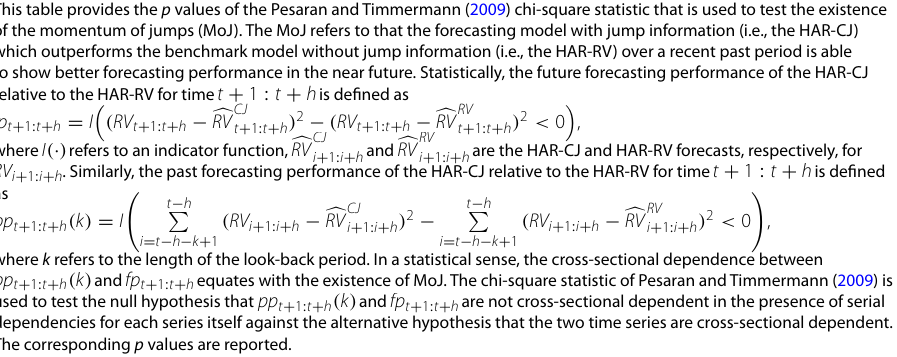
This table provides the p values of the Pesaran and Timmermann (2009) chi-square statistic that is used to test the existence of the momentum of jumps (MoJ). The MoJ refers to that the forecasting model with jump information (i.e., the HAR-CJ) which outperforms the benchmark model without jump information (i.e., the HAR-RV) over a recent past period is able to show better forecasting performance in the near future. Statistically, the future forecasting performance of the HAR-CJ 1 t h is defined as relative to the HAR-RV for time t + : +